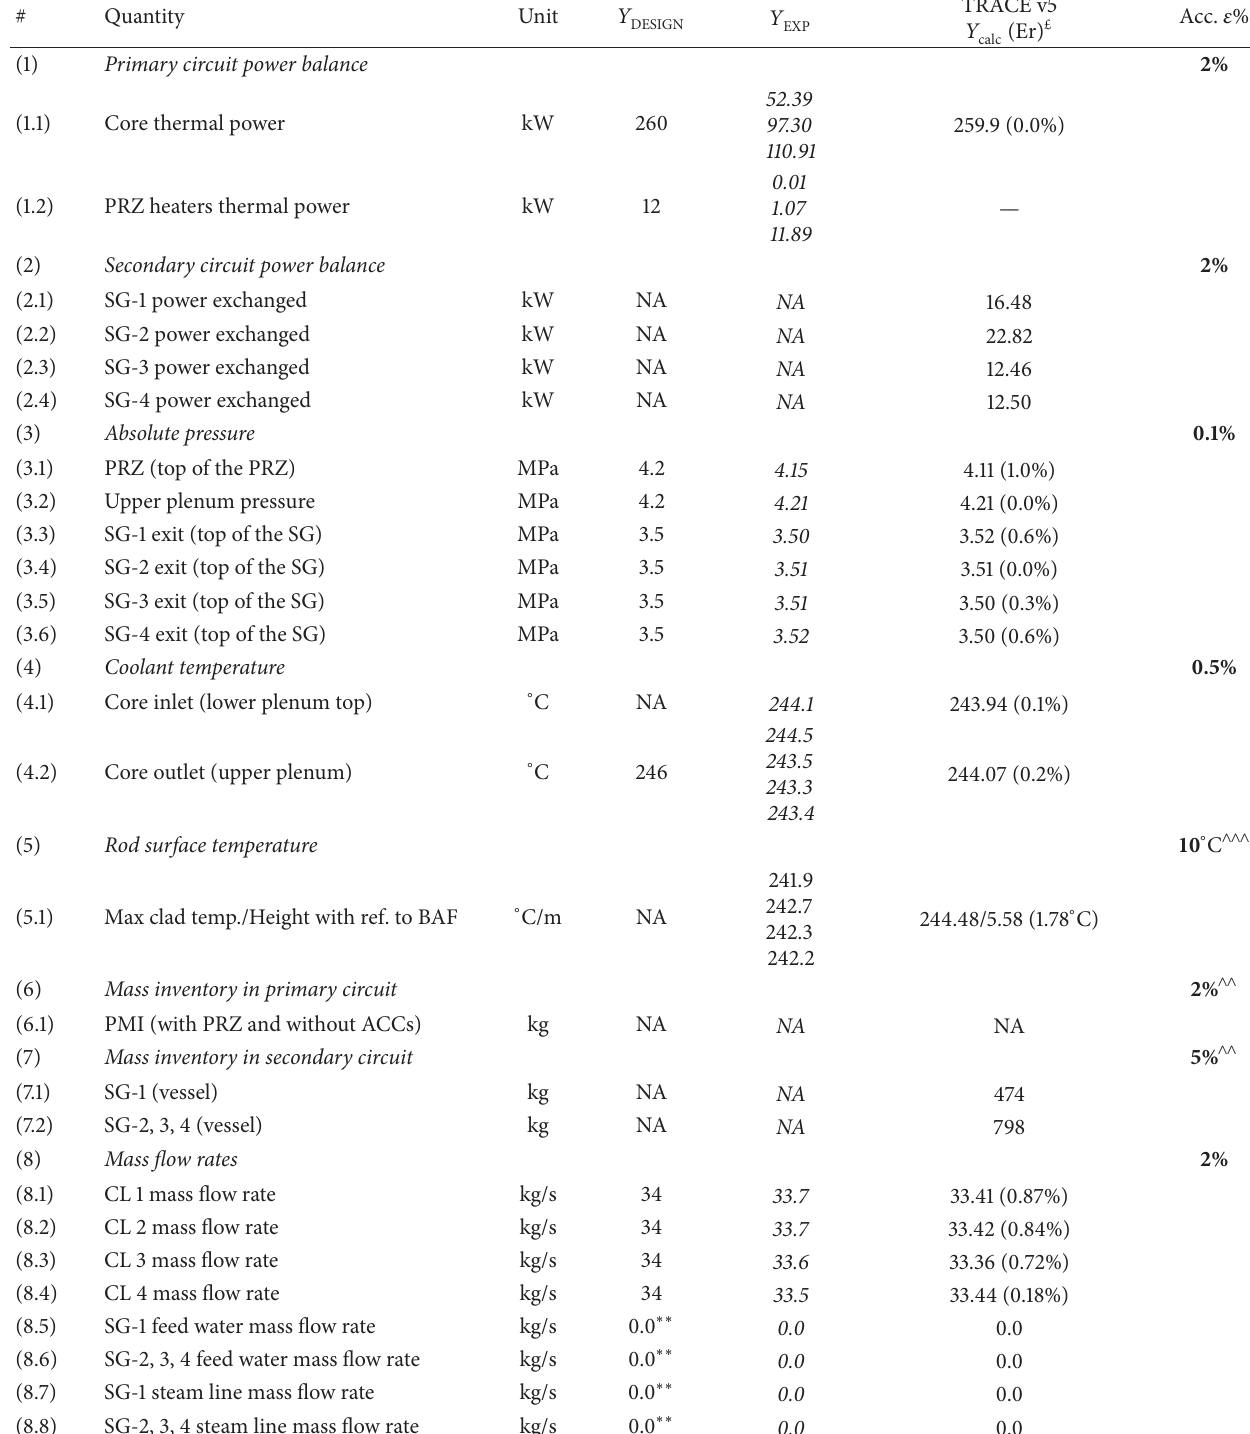
Table 1: Post test: steady state